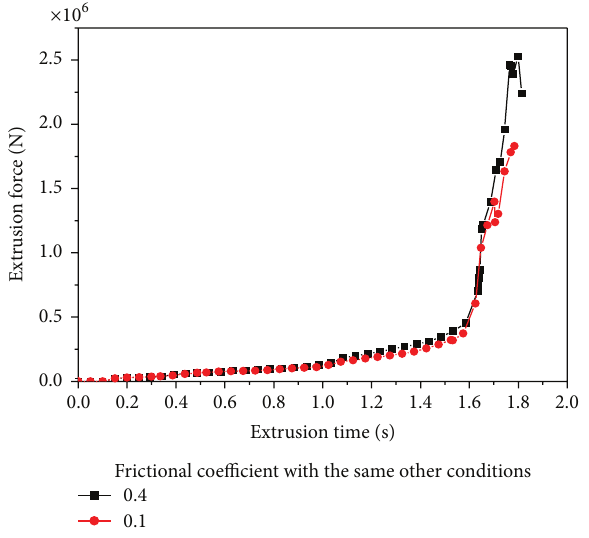
Figure 7: ES extrusion loads for various friction factors.